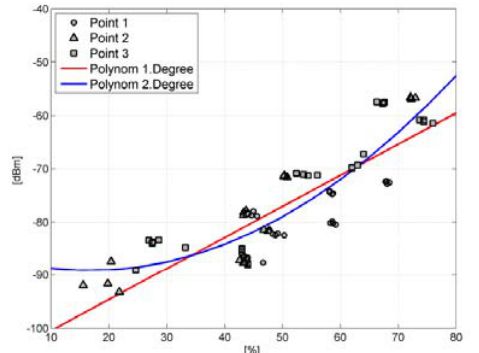
Figure 11. Polynomial approximation of RSS relationship between a Raspberry Pi unit in [%] and smartphone SM1 in